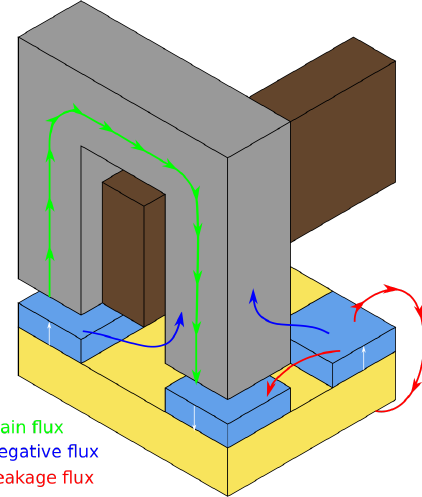
Figure 15. Main, negative and leakage flux of a TFM.